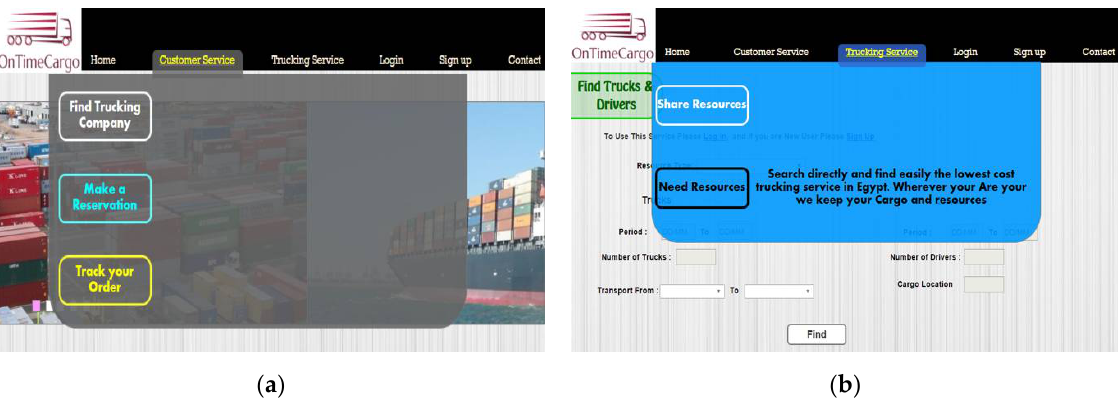
Figure 7. Appearance prototype of the proposed web-based system for cargo transportation; ( a ) Customer service menu; ( b ) Trucking service menu.